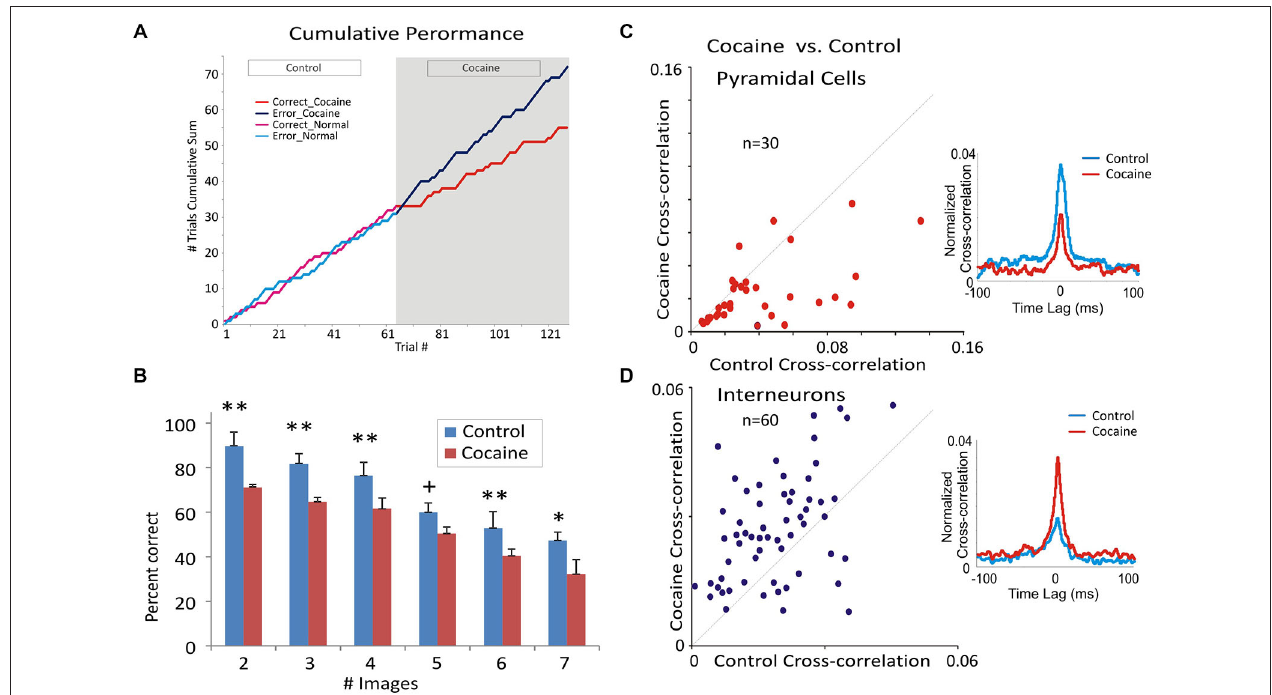
similar. (B) Mean percent correct performance across all animals ( n = 4) as a function of number of distracter images (1–6) in the Match phase during control vs. cocaine halves of the same session ( n = 19). ** F ( 1,96 ) > 11.22, p < 0.001; * F ( 1,96 ) = 10.07, p < 0.01; + F ( 1,96 ) = 3.87, p < 0.05. (C,D) Scatter plots of normalized cross-correlation coefficients from inter-laminar pyramidal cell pairs (C) and interneurons (D) . Insets show opposite variation of the mean cross-correlation histograms CCHs for the same inter-laminar/interneuron cell pairs and in the neural firing in the two subsets of data. Panels (A) , (B) and (C) are adapted with permission from Opris et al.